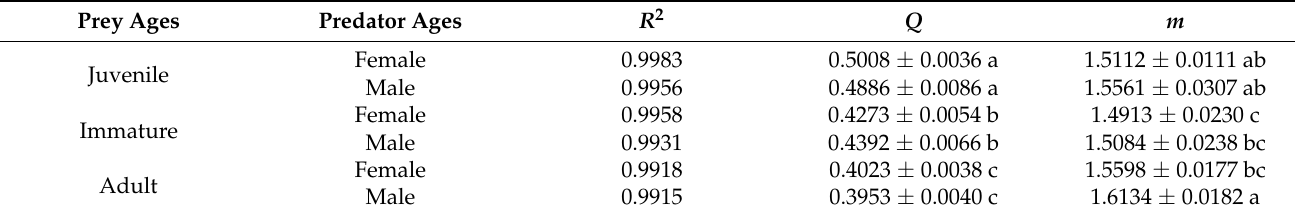
Table 2. Interference response coefficients of C. elysii density to distinct sizes of A. agrestis . Prey